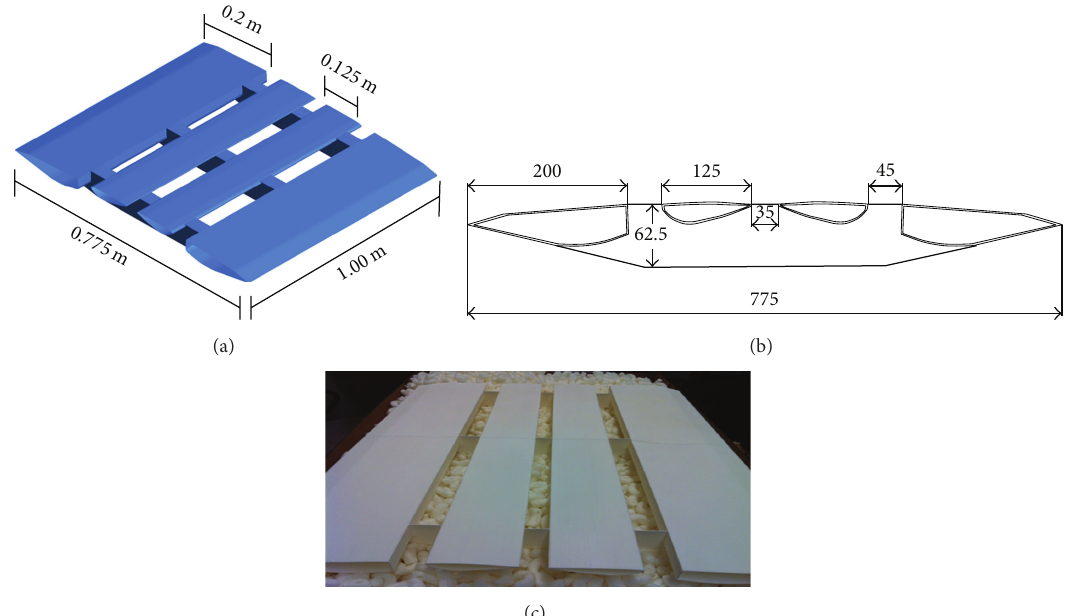
Figure 1: Dimensions of the four deck bridge deck model: (a) general layout (mm), (b) model cross section, and (c) 3D printed ABS hollow shell